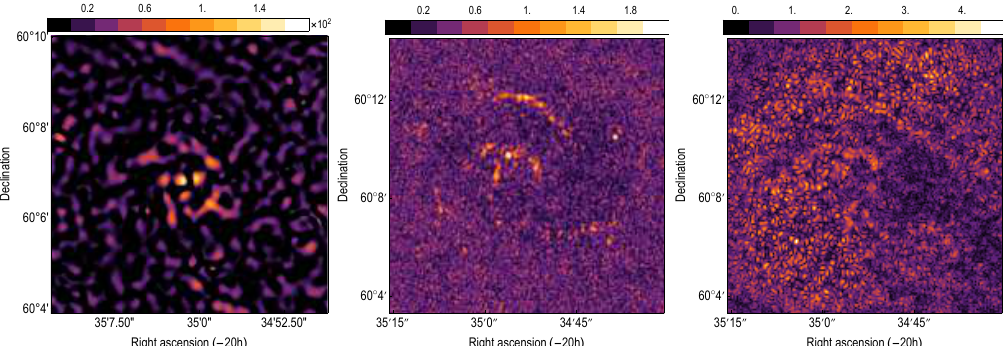
Figure 2. Wavelet coefficient maps at the scales 32, 16 and 8 arcsec (from top to bottom): ( left column ) | W { P }| at λ = 6cm, ( middle column ) w max , ( right column ) | W { F ( φ max ) }| . All are measured with µ